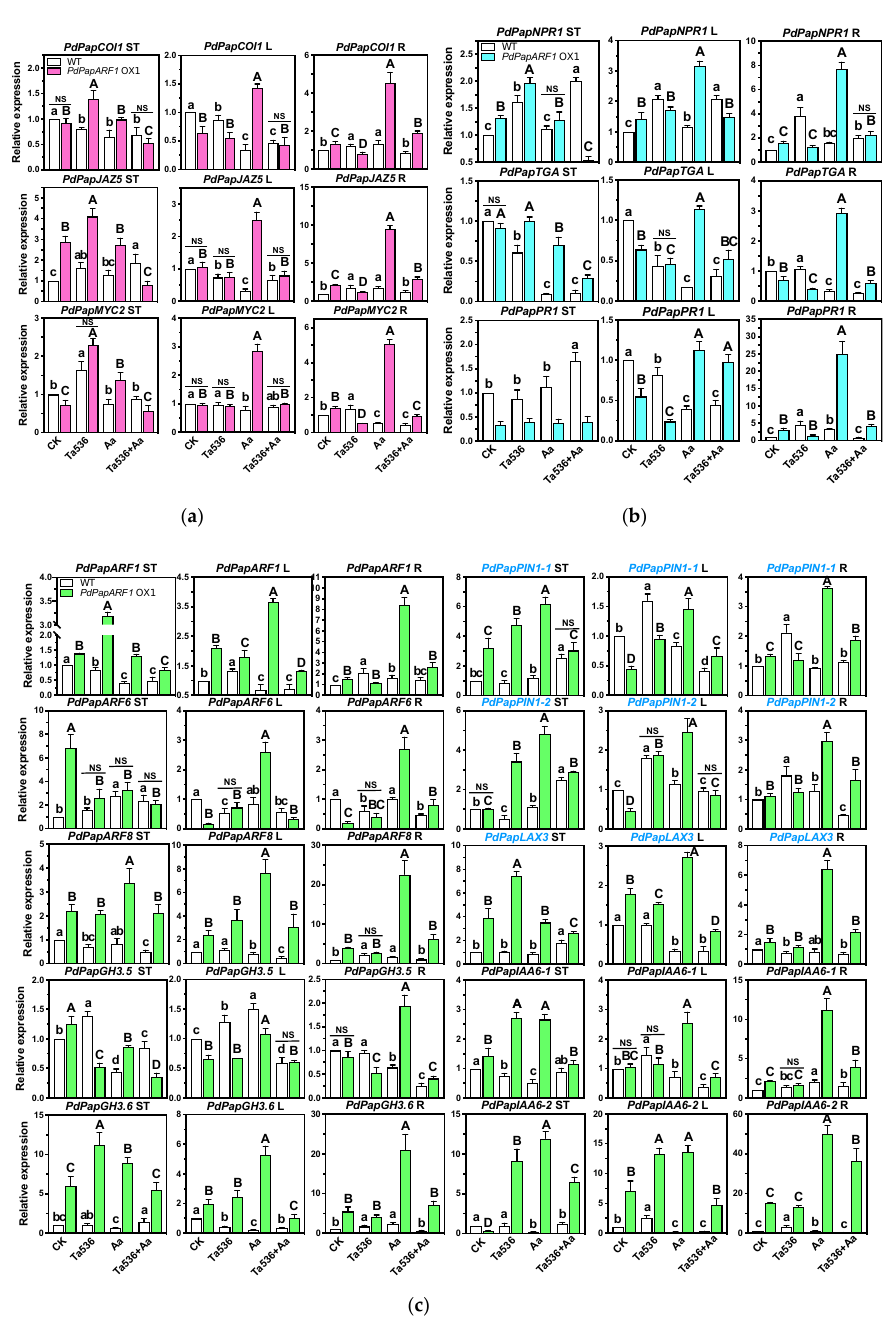
Figure 5. The expression of hormone-signaling-related genes of JA ( a ), SA ( b ), and IAA ( c ) in response to di ff erent fungal inoculations determined by q-RT-PCR. CK, uninoculated control. ST, shoot tip. L, inoculated leaf. R, root. Names of signaling-related genes are in black font, and names of transportation-related genes are in blue. Di ff erent capital letters represent significant di ff erences among the OX plants treated with di ff erent inoculations; di ff erent lowercase letters represent significant di ff erences among the WT plants treated with di ff erent inoculations; insignificant di ff erences are not marked. NS represents that the di ff erence between OX and WT plants undergone the same inoculation is not significant; in the results not marked with NS, significant di ff erence exists between the OX and WT plants. All significances were at p < 0.05. All experiments were performed with three biological replicates with each replicate pooled of three plants and three technical replicates. The replicates of OX plants were the clones of the line